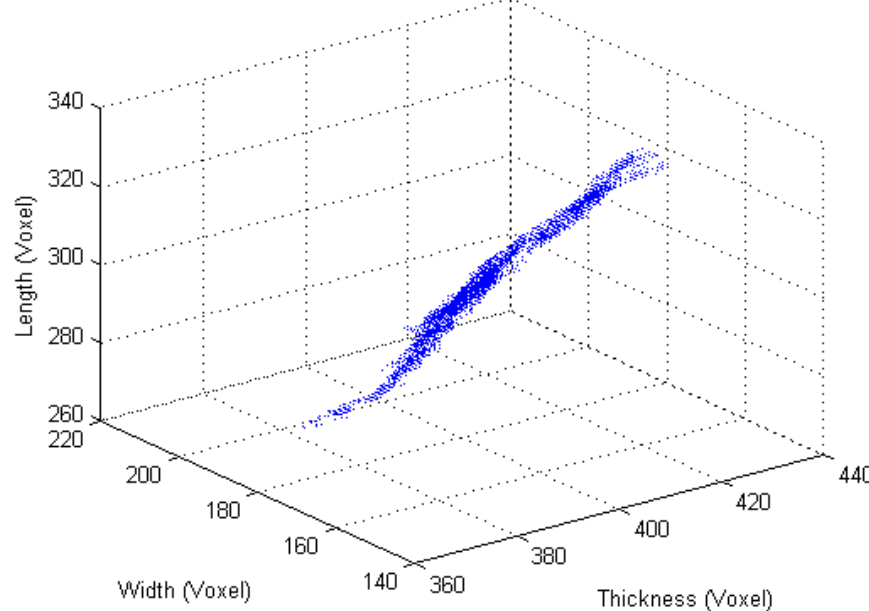
Figure 13. Crack detection results (10 voxels ≈ 7 mm) on the partial anode block with restriction on the investigation box (Initial box dimensions of 100 × 100 × 100 voxels and Ψ = 0.5).